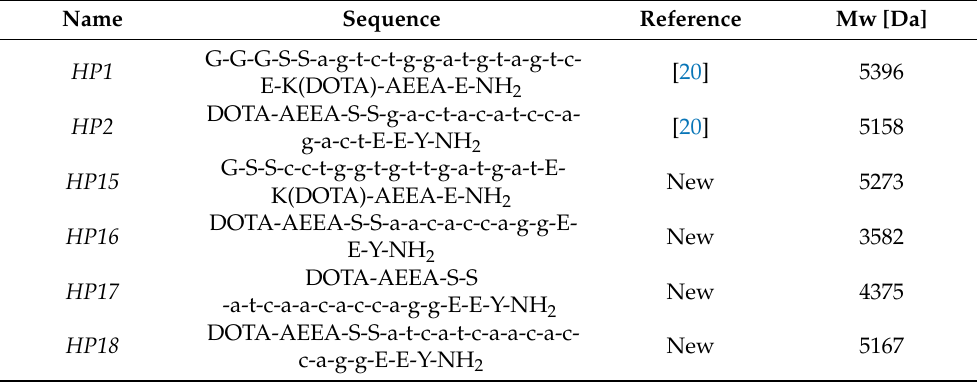
Table 1. Peptide nucleic acid (PNA) probe sequences. Amino acids are denoted by uppercase letters, and PNA monomers are denoted by lowercase letters. DOTA is the chelator